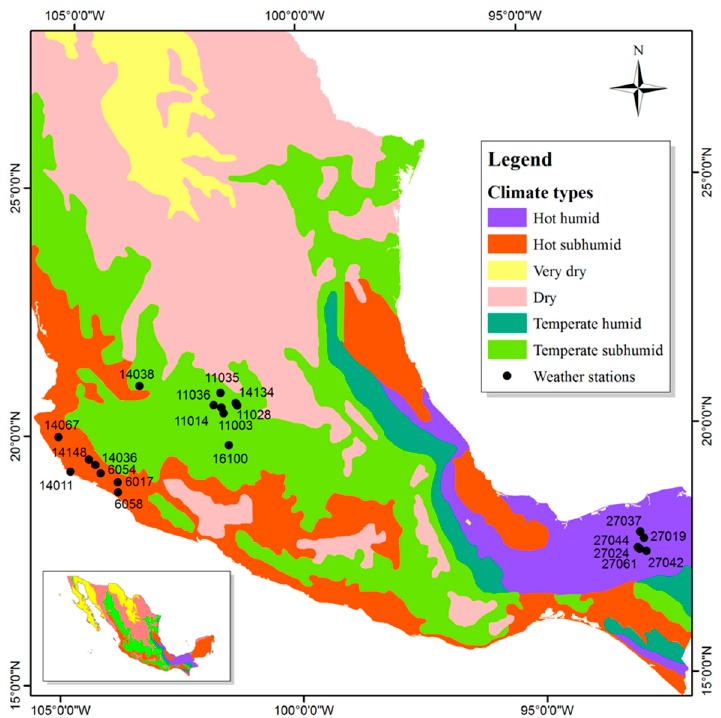
Figure 1. Location of the meteorological stations used in this study.